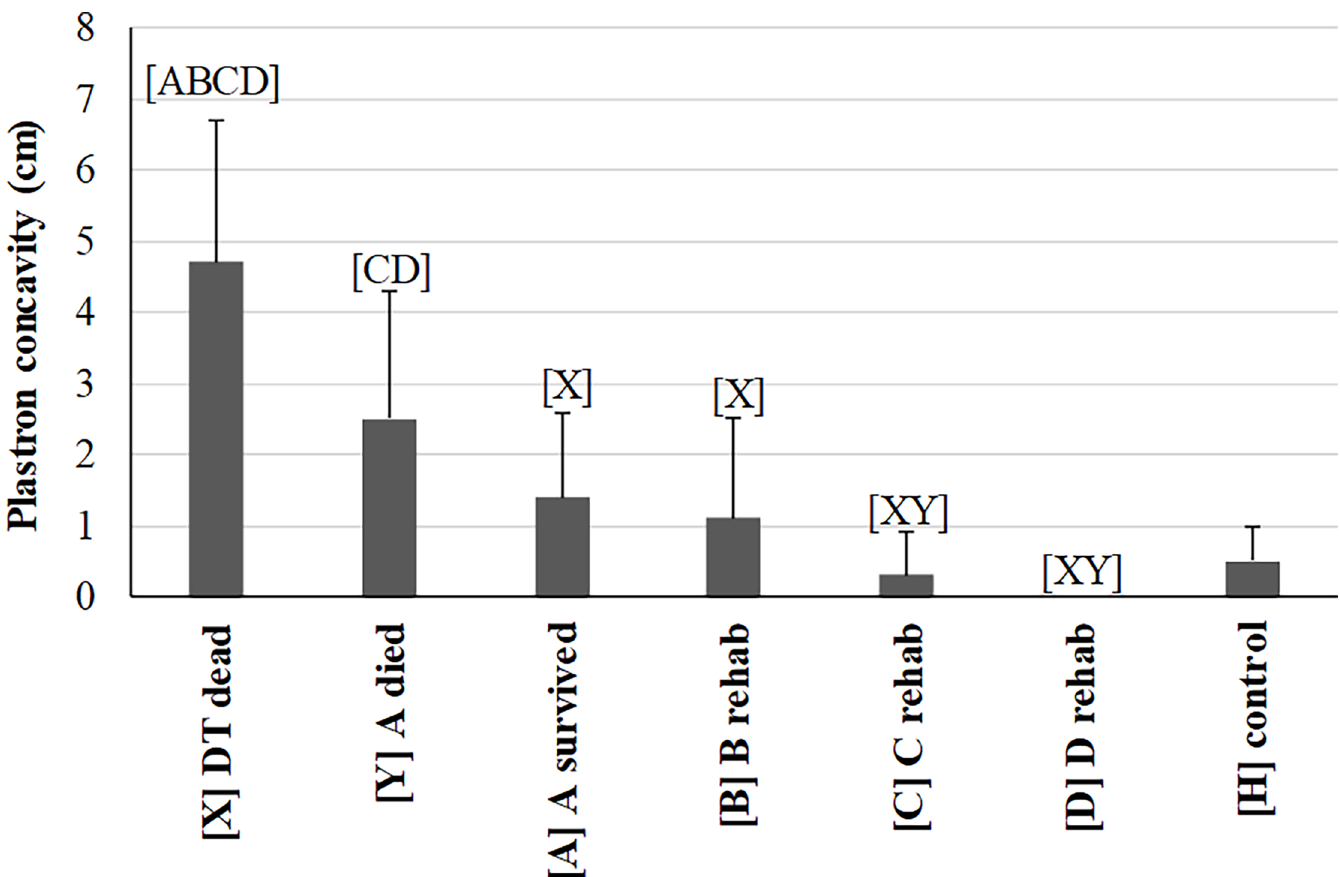
Fig 2. Comparison of plastron concavity measured in debilitated loggerhead sea turtles (DTs) before and during rehabilitation and compared to healthy loggerhead turtles (means and one standard deviation). Lines represent an individual turtle through rehabilitation. Each turtle group on the x-axis was significantly different (p < 0.05 or p < 0.00883 for repeated measures) from groups represented by letters above data. Sample size for each group: 15 [X], 9 [Y], 6 [A]–[D],